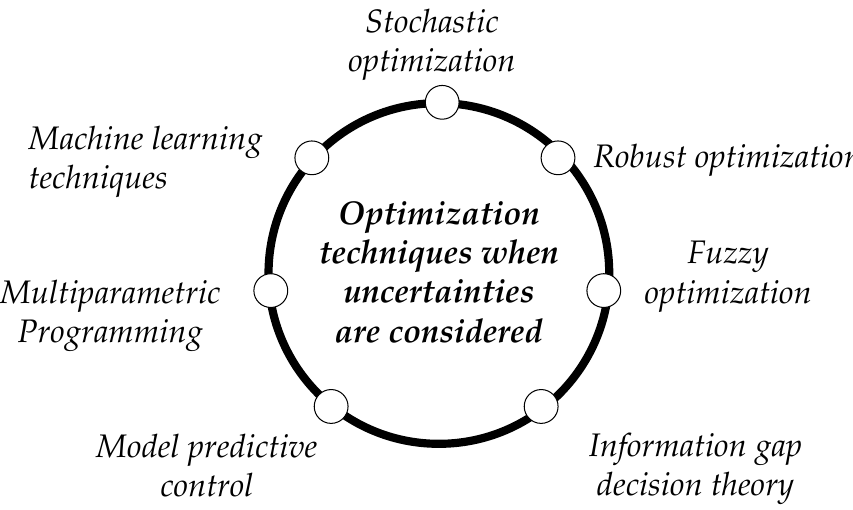
Figure 5. Optimization techniques when uncertainties are considered in microgrids